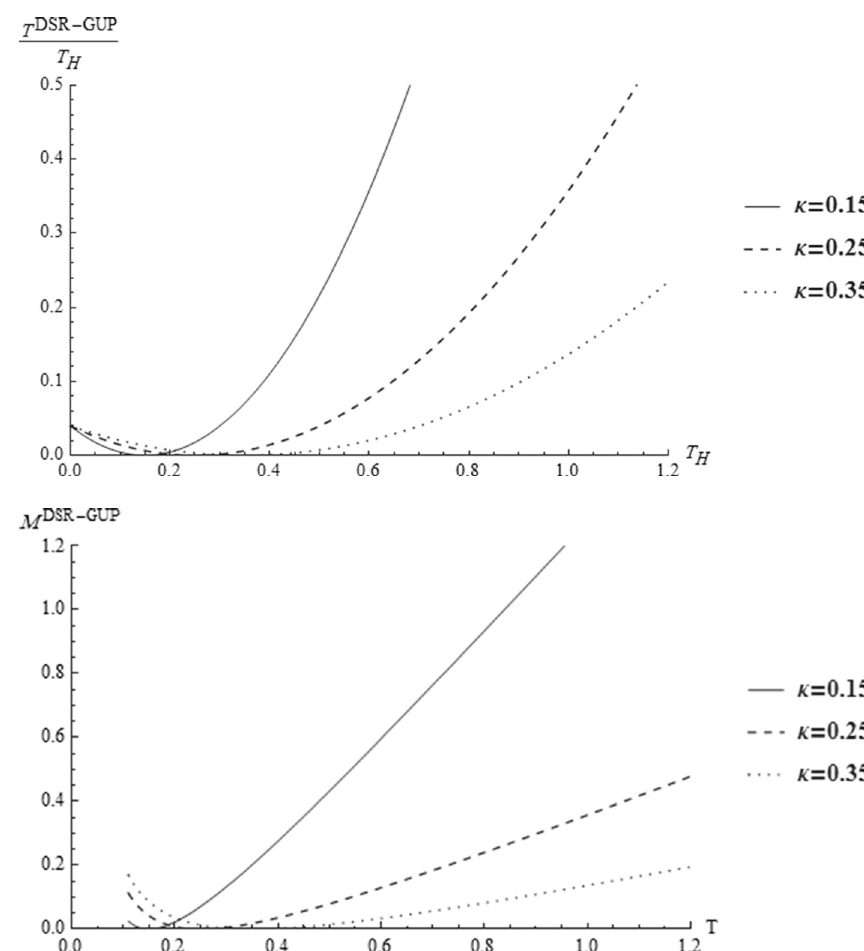
Fig. 2 Plot of the modified temperature-Hawking temperature relation for the T DSR − GUP with κ = 0 . 15 , 0 . 25 H